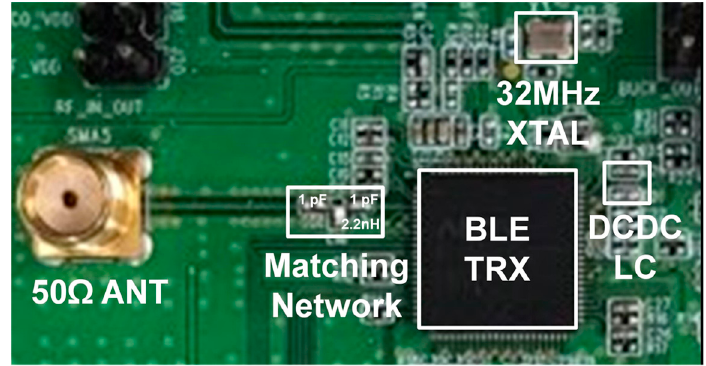
Figure 21. Measurement board of the BLE transceiver.